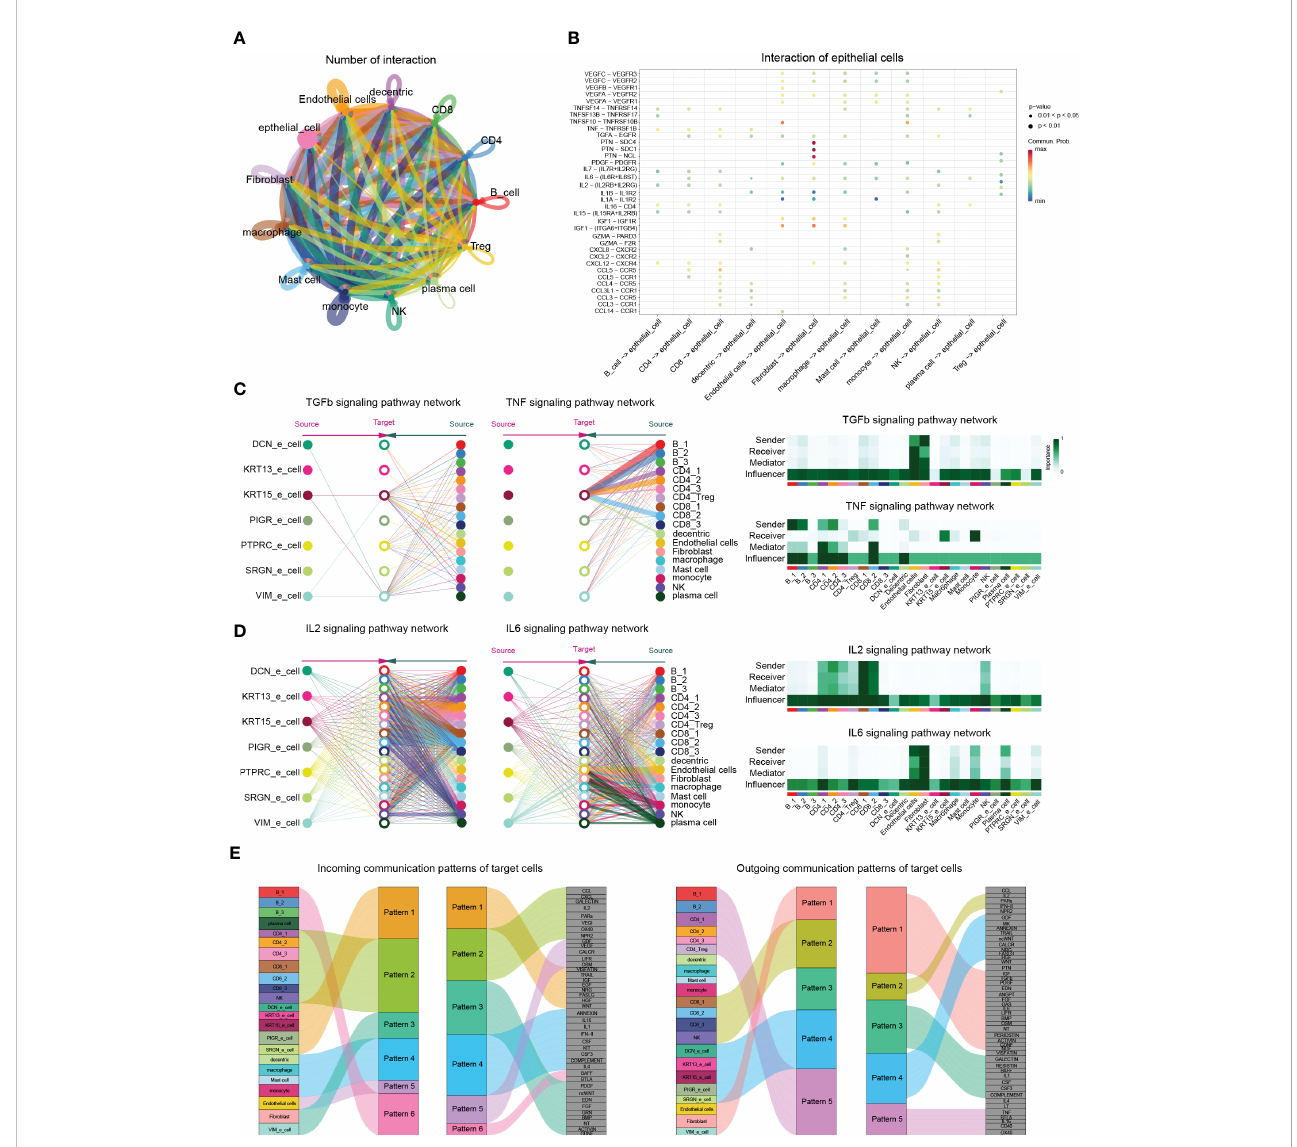
FIGURE 6 CellChat analysis postulates cell-cell interactions in cystitis glandularis. (A) The ability of cell communication between different cell types. Each cell type and their corresponding cellular signals are indicated by different colors. The arrows on the lines represent the direction in which cell signals are acting. The thickness of the lines represents the number of ligands and the intensity of cell signaling between different cell types. (B) Cell signals from different cell types to epithelial cells. The vertical axis shows the interaction between receptors and ligands in selected cell types, with different colors representing intensity. (C, D) Schematic diagram of the TGFb, TNF, IL2, and IL6 signaling pathways in each cell subset. (left) Strati fi ed plots showing autocrine and paracrine effects of all cell subsets in each cell type. Each cell type is colored differently, and the thickness of the line segment indicates the strength of the cell effect. (right) Heat map showing the relative importance of all cell types in cell signaling pathways. According to the roles played by the different cells, they can be divided into sender, receiver, mediator and in fl uencer cells. (E) Incoming (left) and outgoing (right) signaling patterns between secretory cells, demonstrating the relationships between various cell subsets with signaling pathways and hypothesized communication patterns. The size of each module represents the strength of the